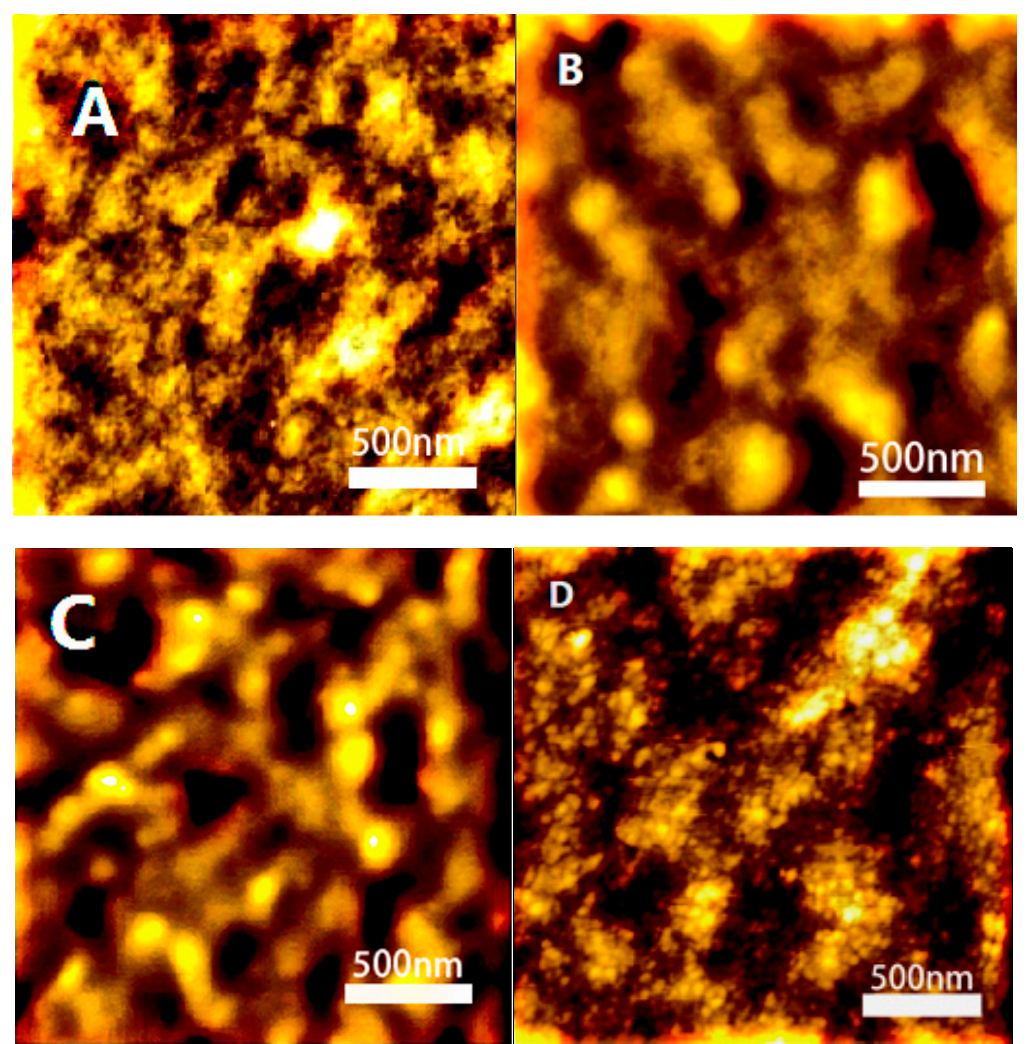
Figure 5. Atomic force microscopy (AFM) topographic images (2 μ m × 2 μ m) of polymer/PC 71 BM blend films. P1 ( A ), P2 ( B ), P3 ( C ) and P4 ( D ).